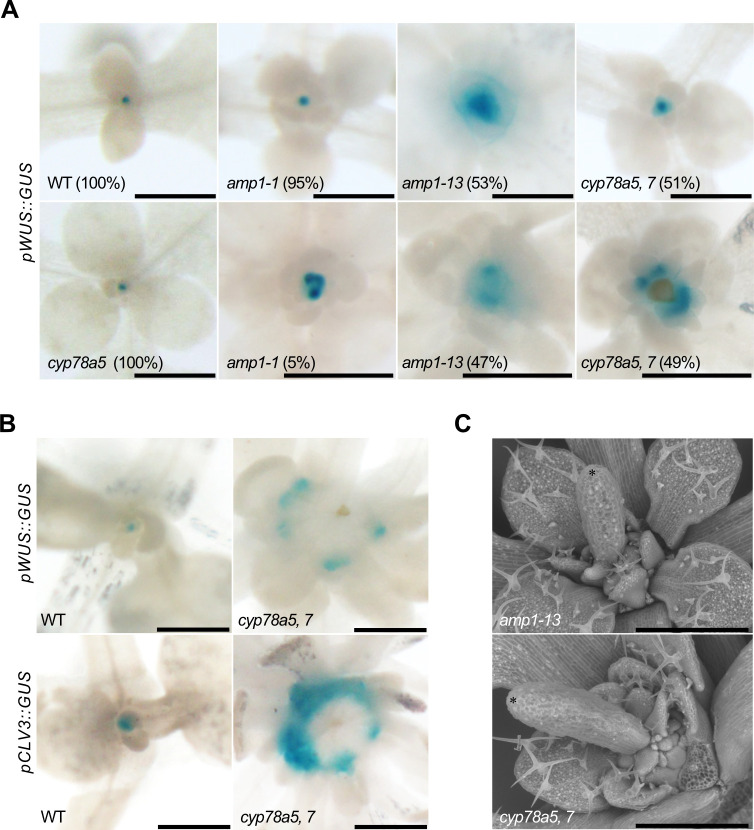
cyp78a5,7 forms ectopic shoot stem cell pools similar to amp1.(A) pWUS::GUS activity in shoots of the indicated genotypes at 7 DAG. The frequencies of shown GUS-staining patterns are stated. (B) pWUS::GUS and pCLV3::GUS activities in shoots of wild type and cyp78a5,7 at 10 DAG. (C) Scanning electron micrographs of shoot apices of 7-day-old amp1-13 and cyp78a5,7 plants showing the presence of a central leaf-like structure with radial polarity (black asterisk marks the tip of the structure). Leaf primordia were partially to visualize meristematic structures. Size bars represent 500 μm (A,B and C).